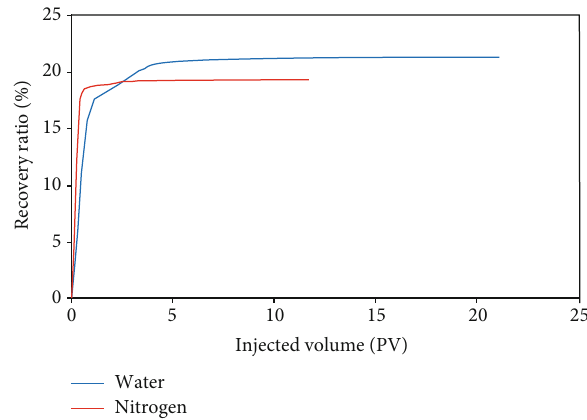
Figure 3: Curve of the relationship between injection volume and sweep e ffi ciency in di ff erent media.